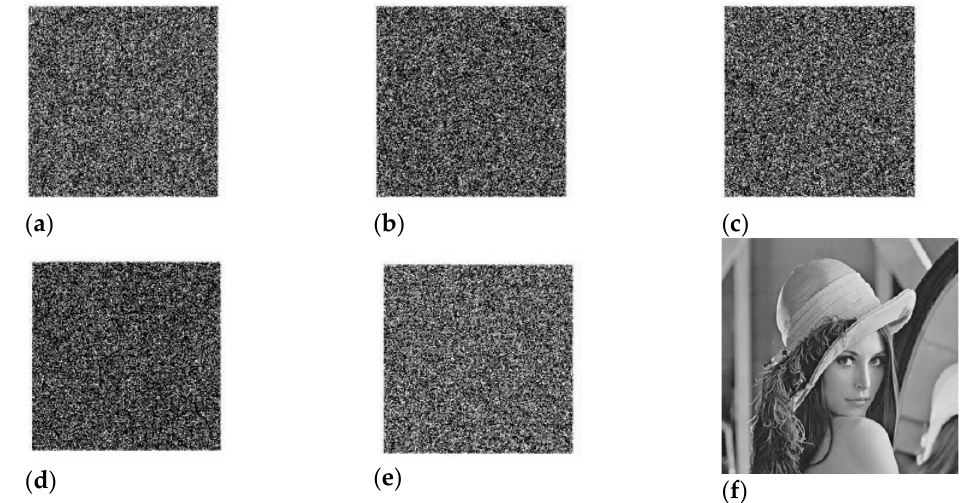
Figure 7. Encrypted image ‘Lena’ reconstructed using the wrong key ( a ) × 10 = 0.56 + 1.0000 × 10 − 14 , ( b ) × 20 = 0.49 + 1.0000 × 10 − 14 , ( c ) × 30 = 0.76 + 1.0000 × 10 − 14 , ( d ) K1 = 115.7100 + 1.0000 × 10 − 14 , ( e ) K2 = 395.0100 + 1.0000 × 10 − 13 , ( f ) K3 = 203.4900 + 1.0000 × 10 − 13 .